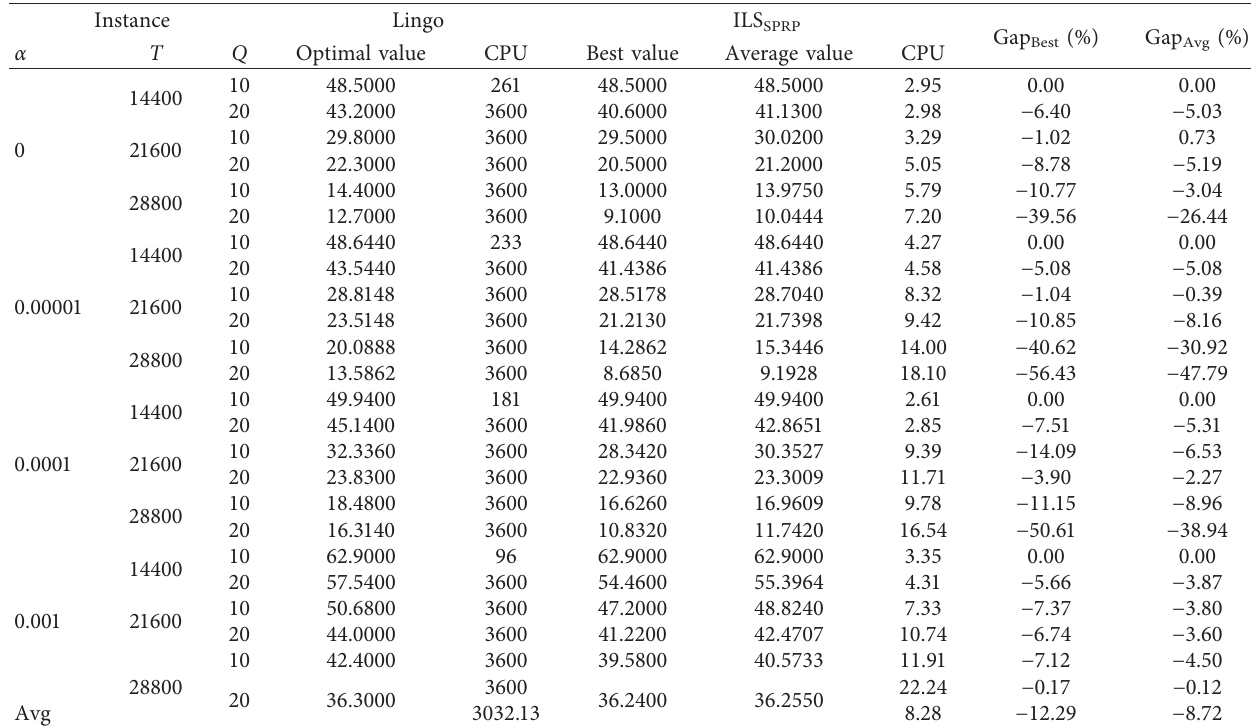
Table 9: Sensitivity analysis on α .